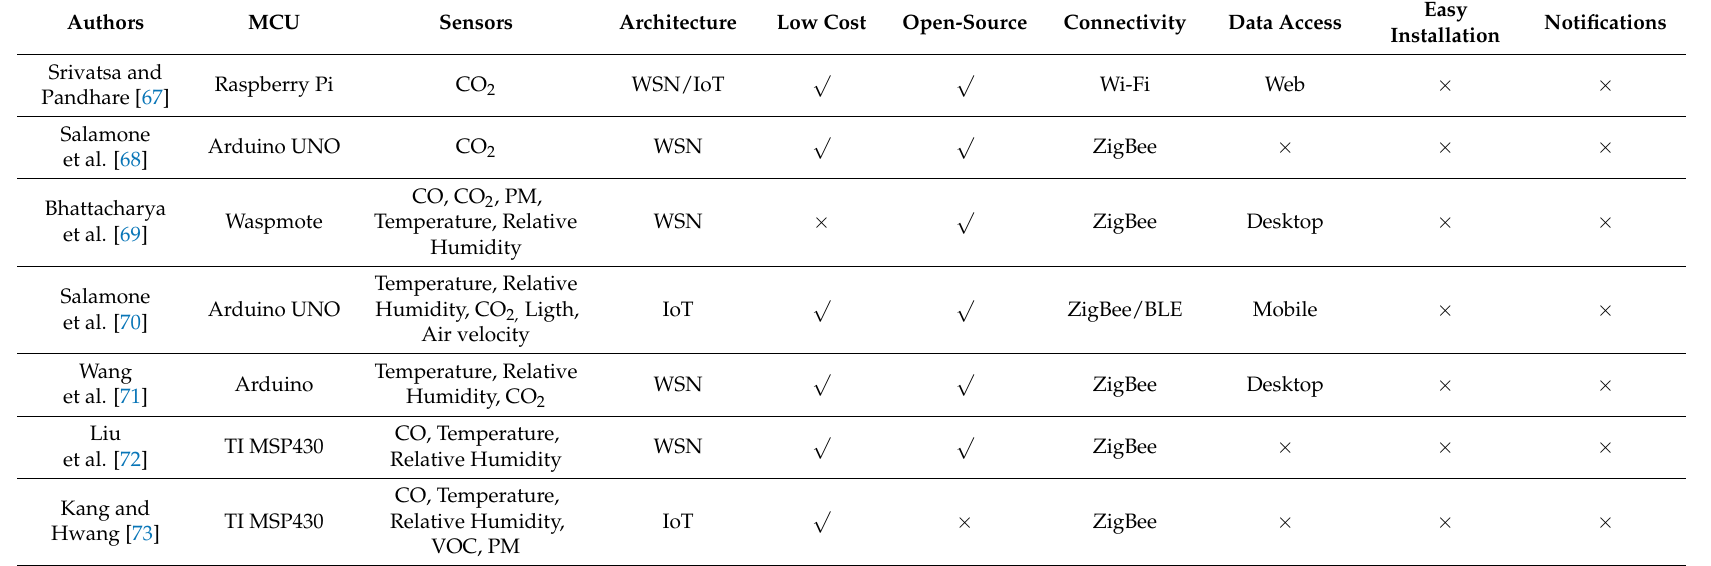
Table 5. A summary of the similar types of research on IoT platforms for real-time IAQ